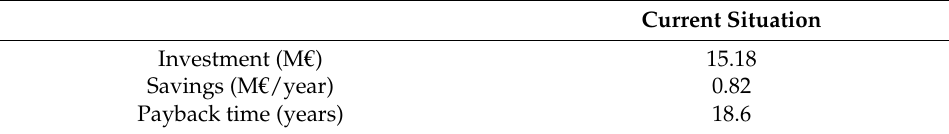
Table 14. Summary of economic result for the chosen